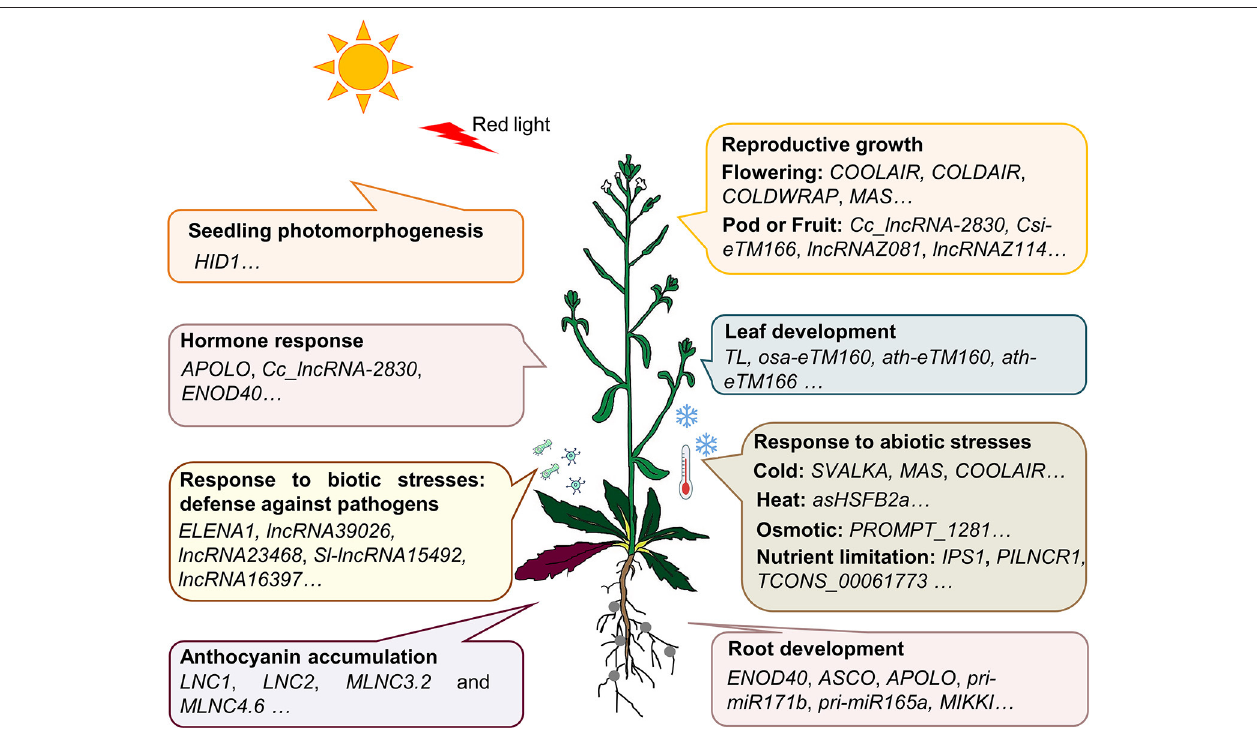
FIGURE 2 | LncRNAs play extensive roles in most aspects of plant growth and development. During plant growth and development, multiple lncRNAs are validated to play crucial roles. HID1 plays an active role in seedling photomorphogenesis under continuous red light; APOLO , Cc_lncRNA-2830 , and ENOD40 were demonstrated to respond to the auxin treatment; ELENA1 , lncRNA39026 , and lncRNA23468 enhance resistance to pathogen attacks; COOLAIR , COLDAIR , COLDWRAP , and MAS respond to cold, and involve in regulating the flowering time in vernalization; TL , osa-eTM160 , ath-eTM160 , and ath-eTM166 affect the leaf shape; SVALKA regulates cold signal transduction; asHSFB2a is induced by heat stress and affects grain yield; IPS1 and PILNCR1 are induced by phosphate deficiency; TCONS_00061773 respond to nitrate signal; LNC1 , LNC2 , MLNC3.2 , and MLNC4.6 are involved in anthocyanin accumulation; ENOD40 , APOLO , pri-miR171b , pri-miR165a , and MIKKI are involved in root nodule organogenesis or lateral root